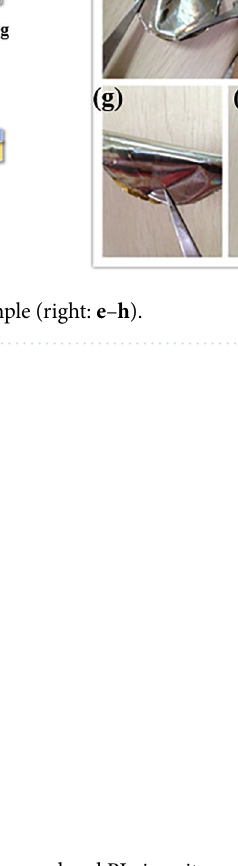
Figure 2. The relationship between the PI layer thickness, rotation speed and PI